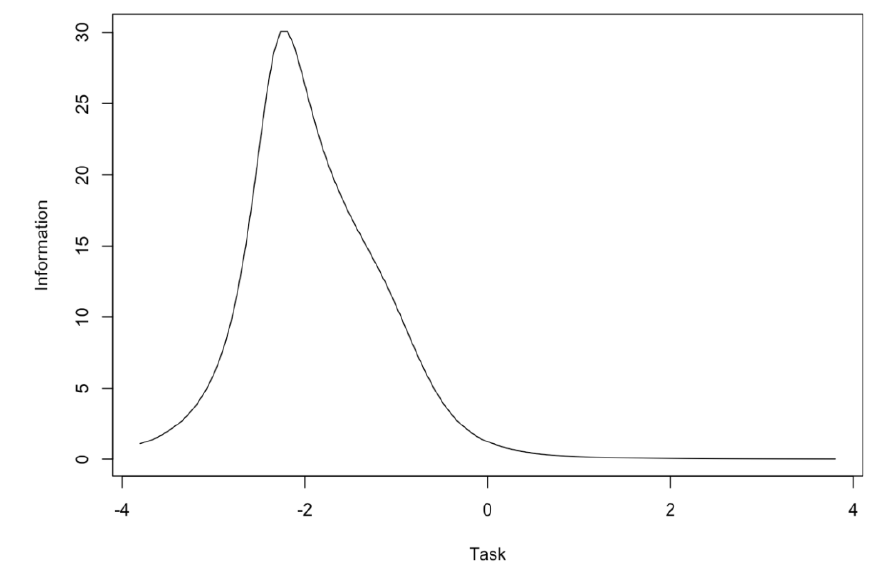
Figure 4. Information curve for the task subscale.